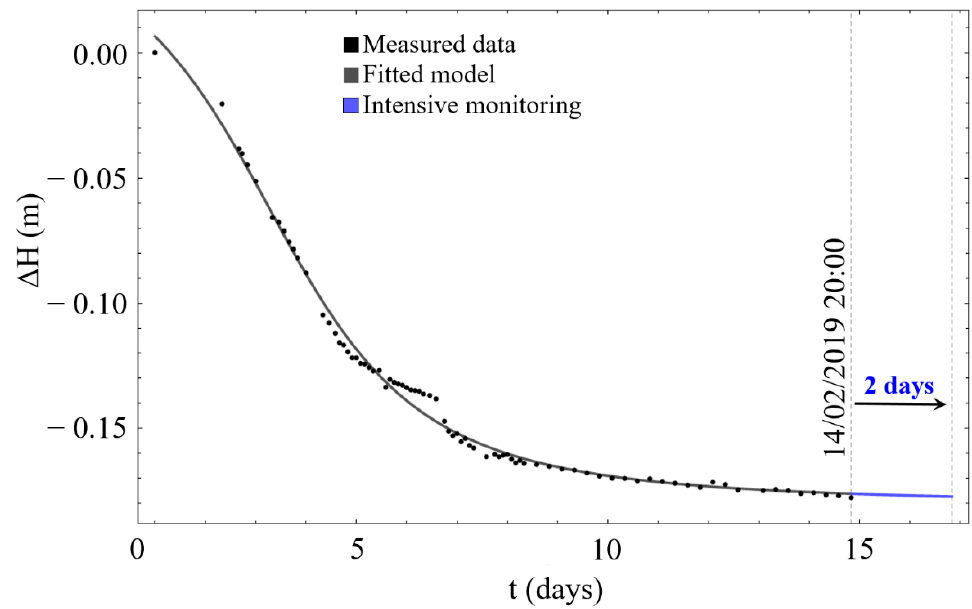
Figure 16. First monitoring adjustment for point MG19. Minerals 2020 , 10 , x FOR PEER REVIEW